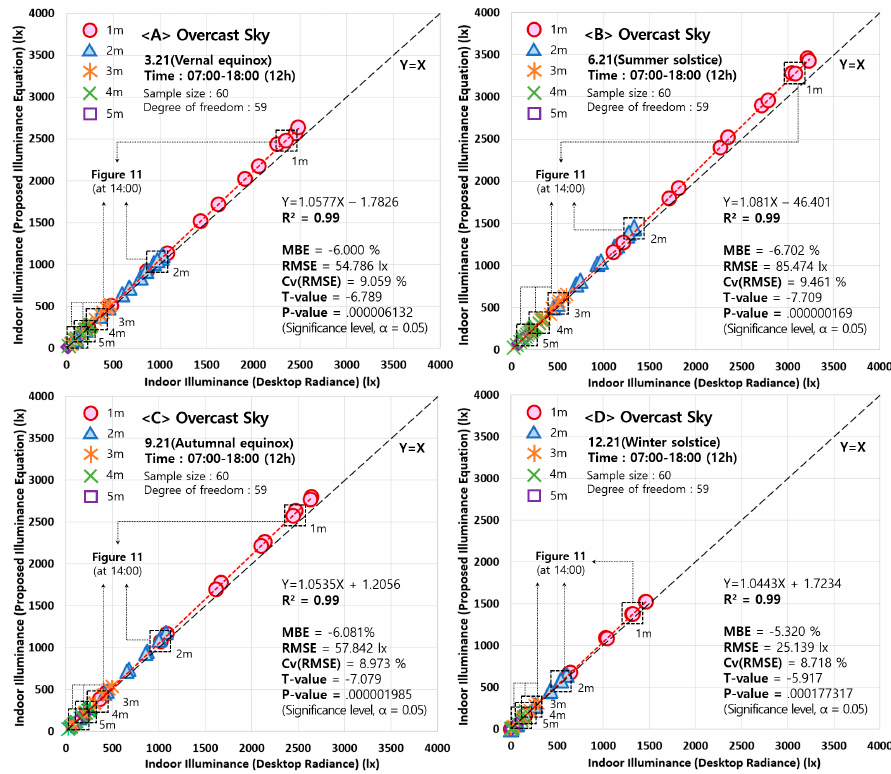
Figure 12. Comparison of indoor illuminance between the modified equation and Desktop Radiance in CIE overcast sky ( A ) 3.21 ( B ) 6.21 ( C ) 9.21 (07:00–18:00) ( D ) 12.21 (07:00–18:00).